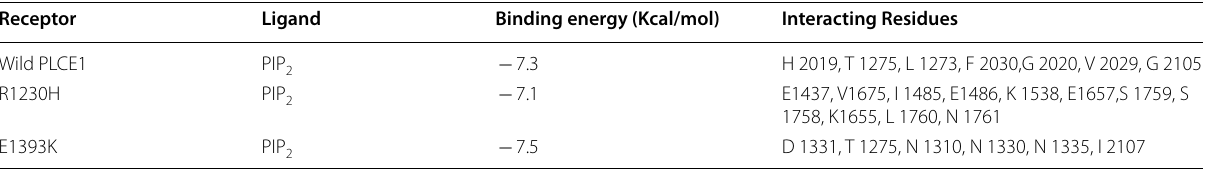
Table 13 Summary of AutoDock Vina Results Receptor